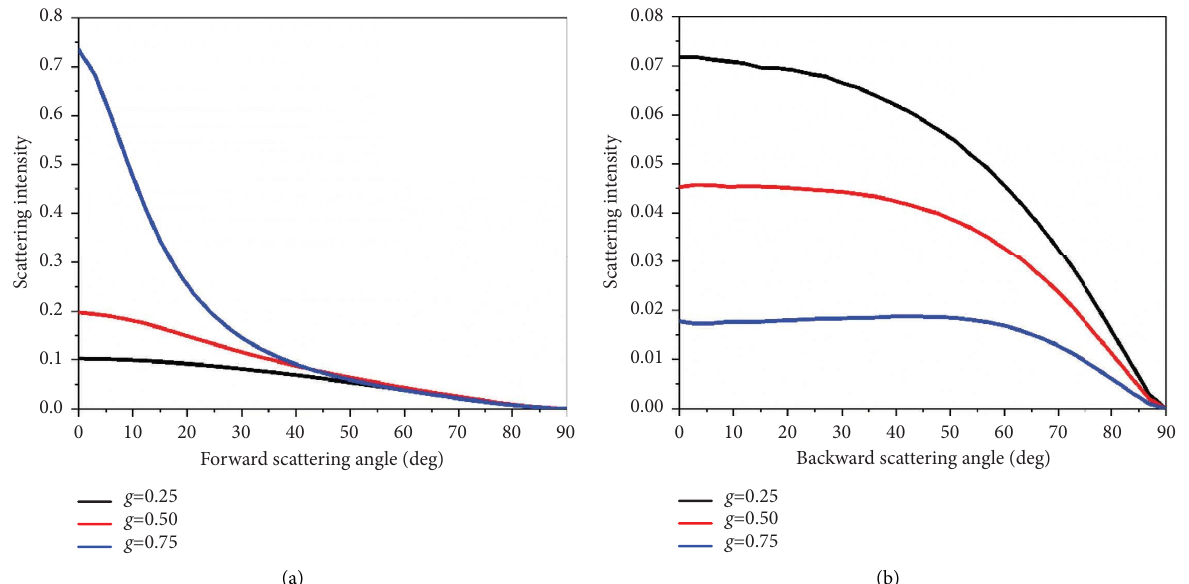
Figure 6: Te scattering intensity versus scattering angle for diferent asymmetry